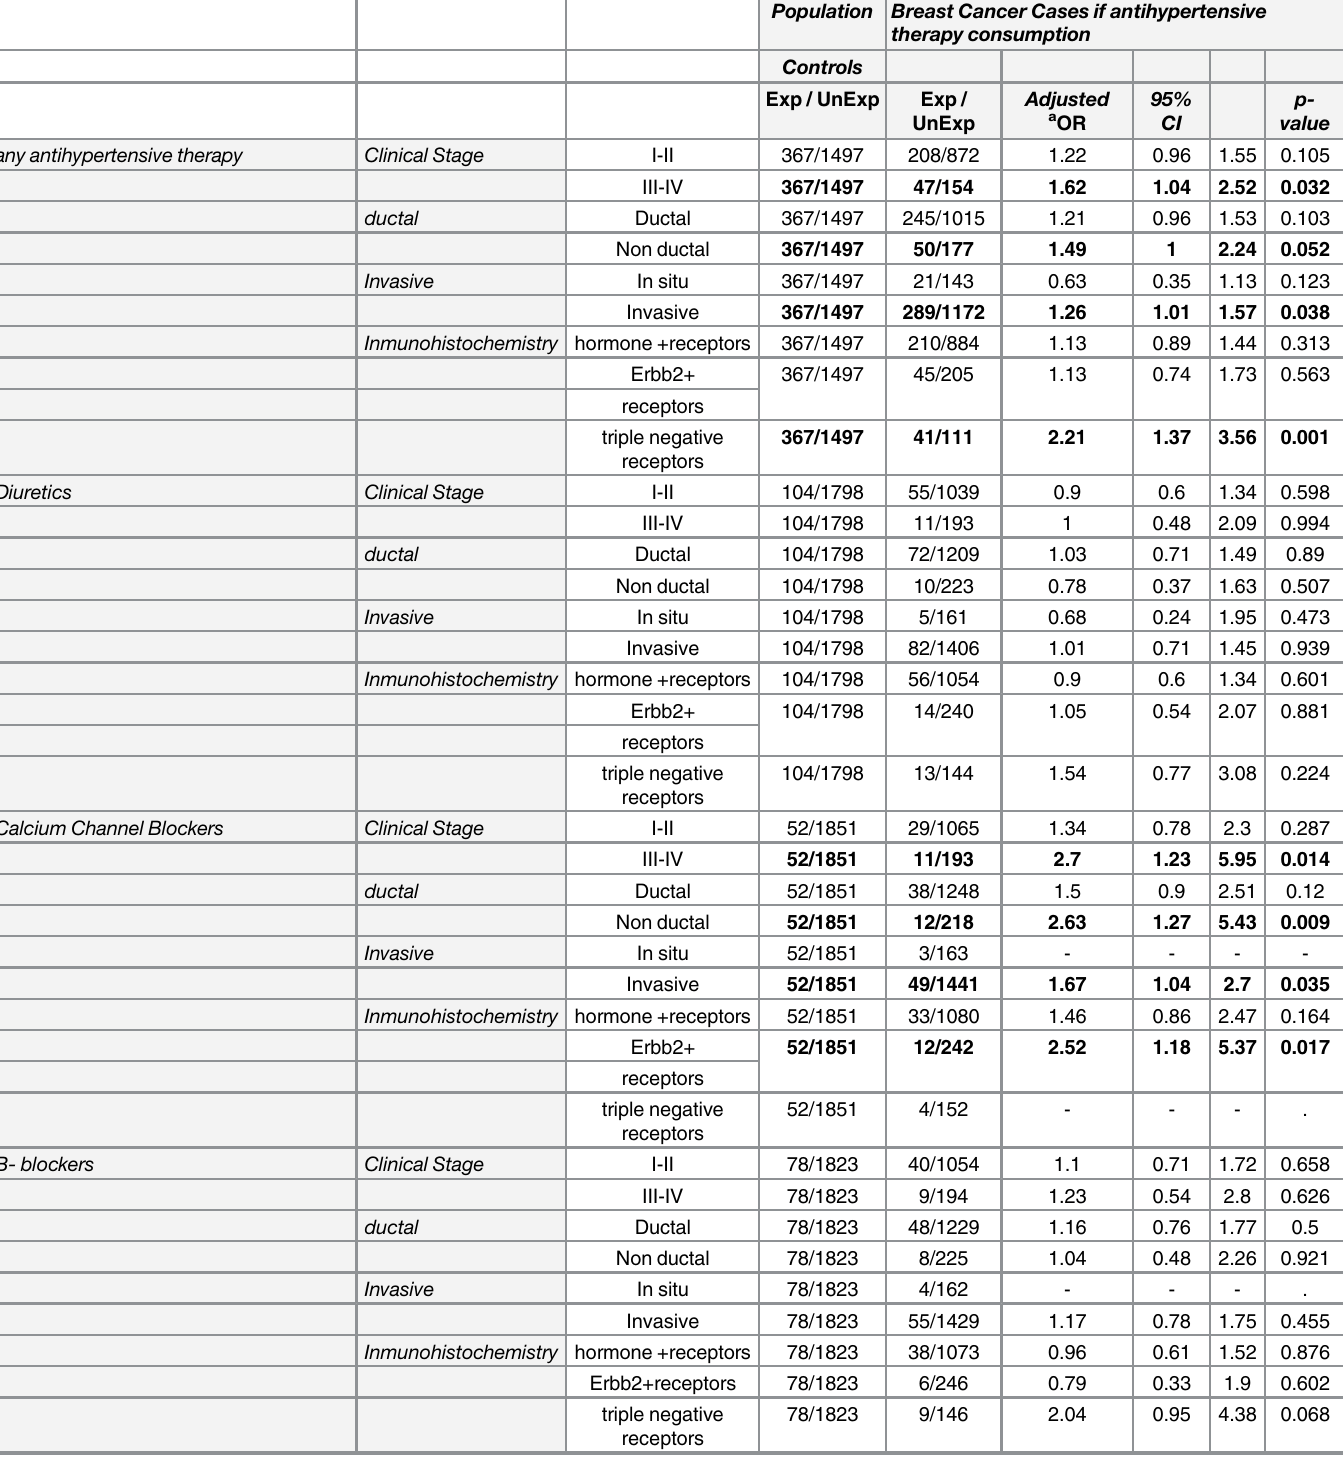
Table 4. Relationship between antihypertensive drug consumption and breast cancer according to tumor characteristic. Category reference: no antihypertensive